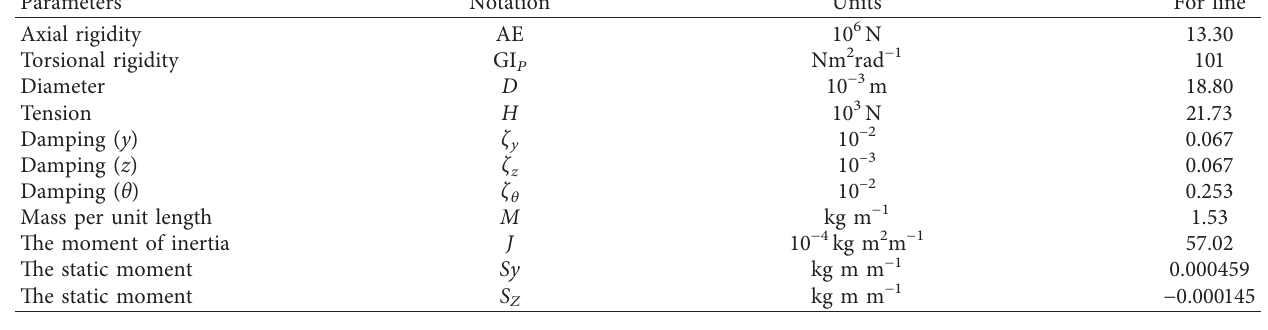
Table 1: Physical parameters of the conductor.